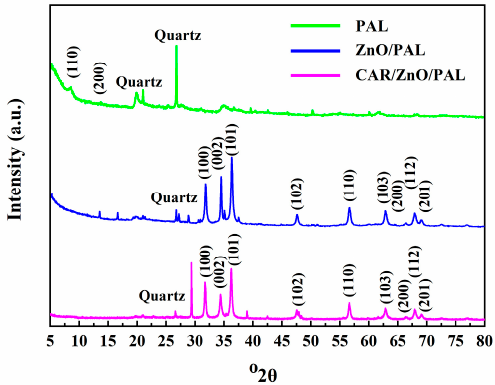
Figure 3. XRD pattern of PAL, ZnO/PAL, and